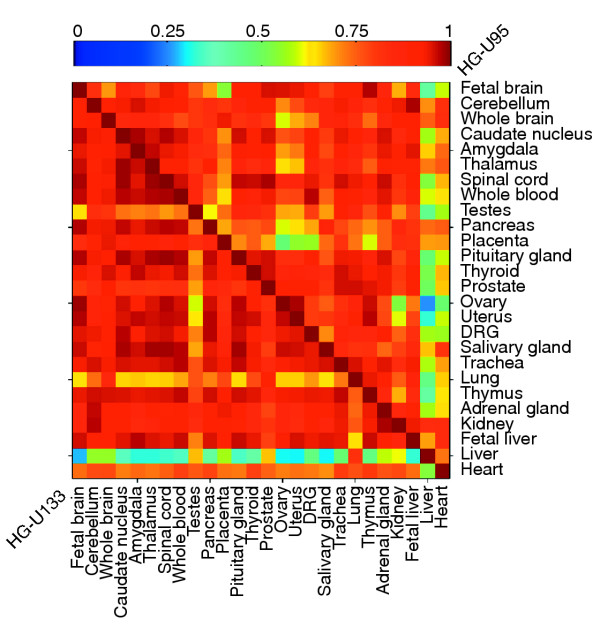
Correlation of mRNA expression levels of 20 known splicing factors (see Materials and methods) across 26 human tissues (lower diagonal: data from Affymetrix HU-133A DNA microarray experiment [45]; upper diagonal: data from Affymetrix HU-95A DNA microarray experiment [43]). Small squares are colored to represent the extent of the correlation between the mRNA expression patterns of the 20 splicing factor genes in each pair of tissues (see scale at top of figure).